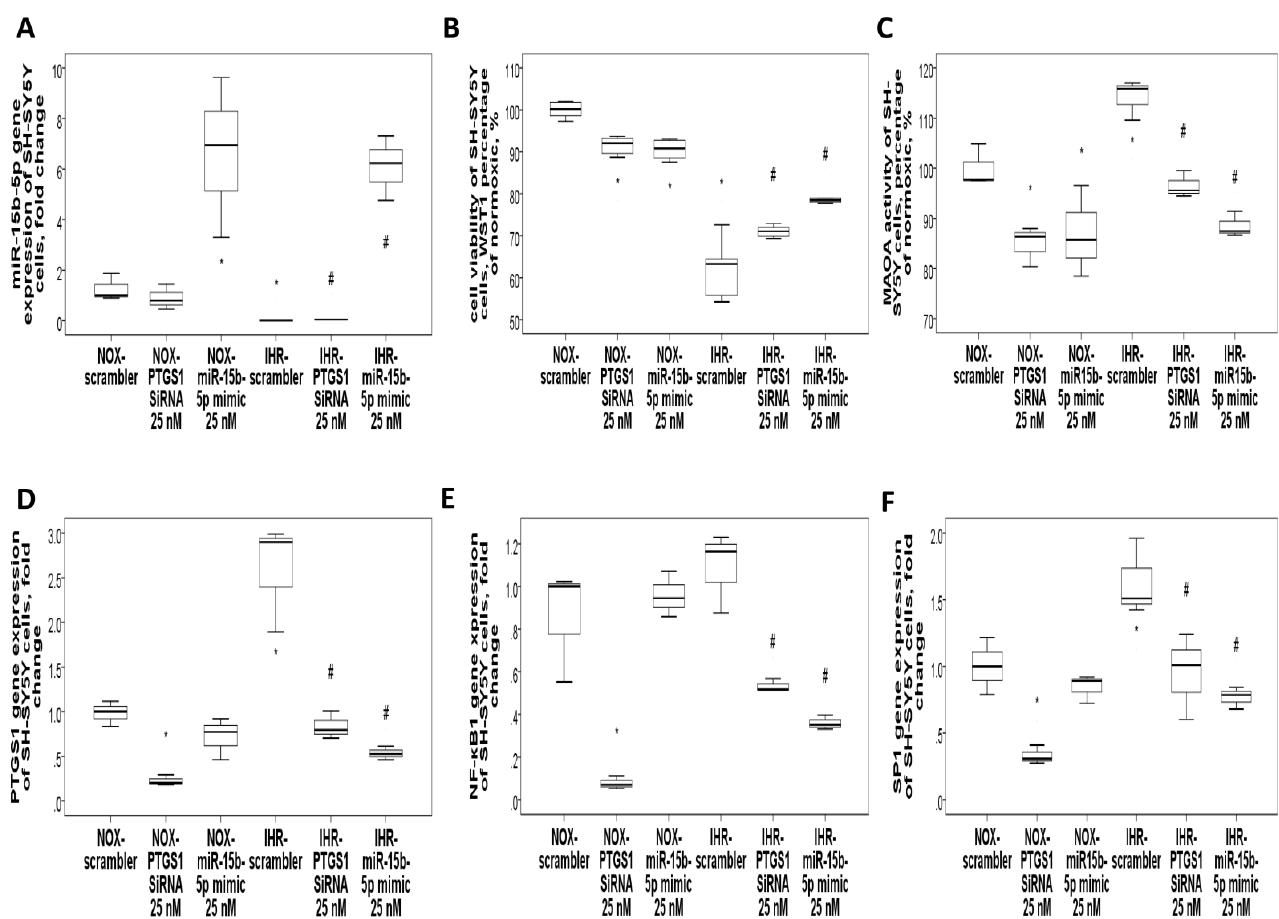
Figure 8. Over-expression of miR-15b-5p or knockdown of PTGS1 reversed intermittent hypoxia with re-oxygenation (IHR)-induced cell injury and MAOA hyperactivity via targeting NF- κ B1/SP1 signaling. Transfection with either PTGS1 SiRNA or miR-15b-5p mimic in SH-SY5Y neuron cells reversed IHR-induced ( A ) down-regulation of miR-15b-5p, ( B ) cell injury, ( C ) MAOA hyperactivity, and up-regulations of ( D ) PTGS1 , ( E ) NF- κ B1 , and ( F ) SP1 . * p < 0.05 compared with normoxic (NOX) condition. # p < 0.05 compared with IHR condition.